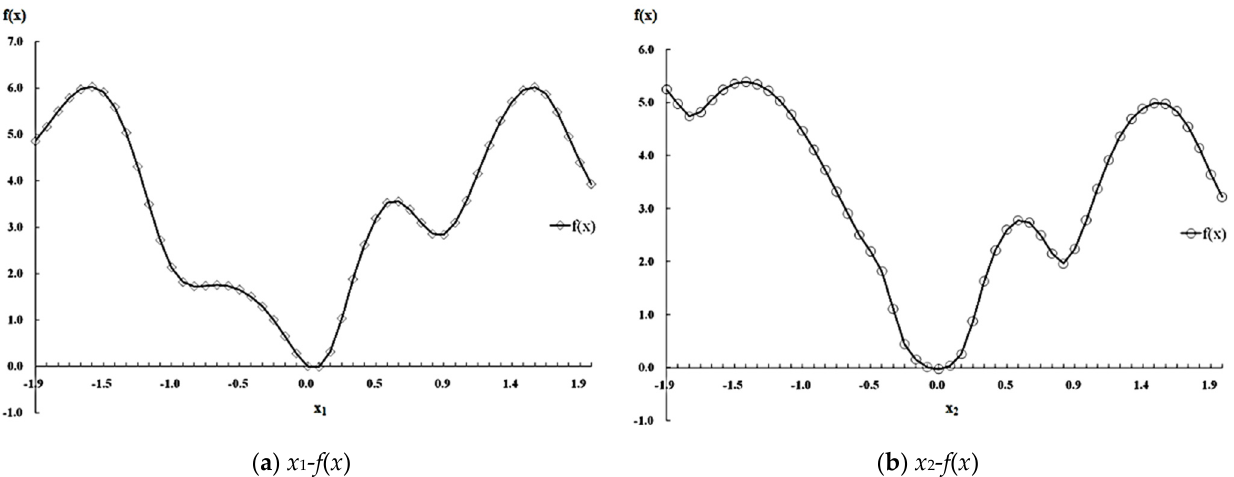
Figure 2. Meta-models on 2-D design space for Ackley’s path function.